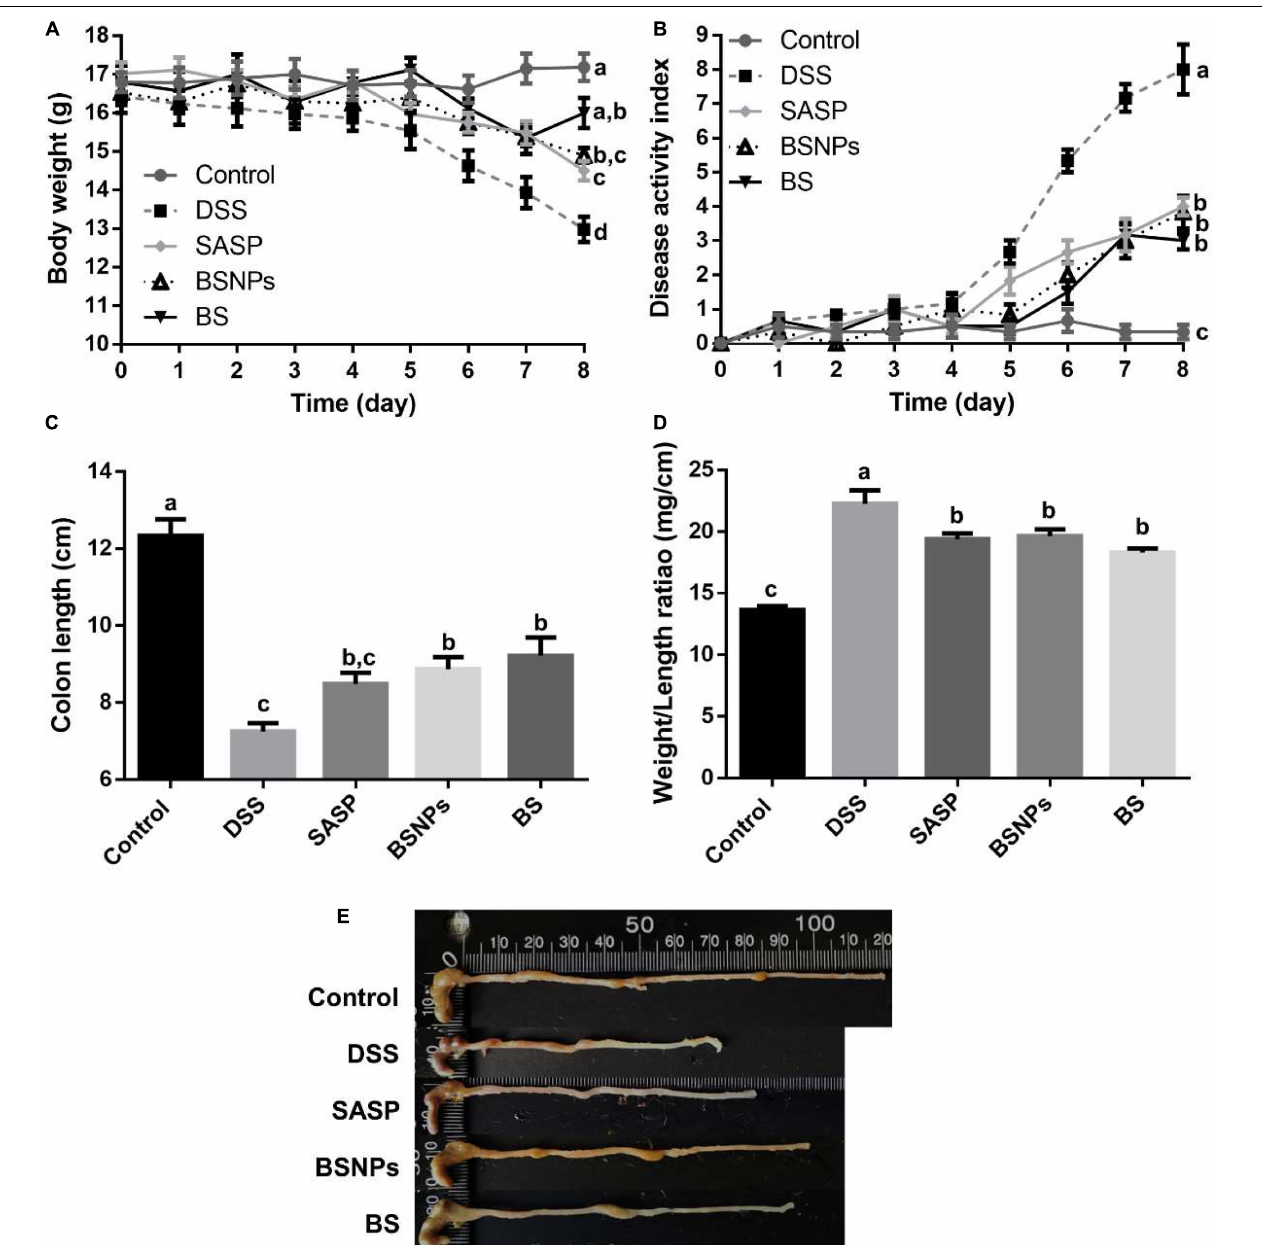
FIGURE 1 | Effect of BS or BSNPs treatment on clinical symptoms of dextran sulfate sodium (DSS)-induced colitis. (A) Bodyweight measurement. (B) Disease activity index. (C) Colon length of mice. (D) Colon weight/length ratio. (E) Representative images of the colon from a different group. Values were expressed as the mean ± SEM ( n = 6). Means without a common letter are significantly different at p < 0.05 using one-way ANOVA followed by Tukey’s test for post hoc